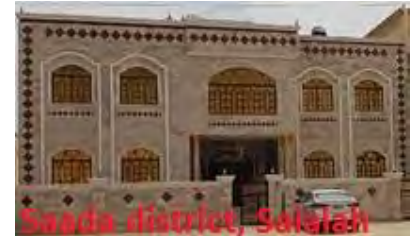
Figure 15. Fac¸ade’s photograph building